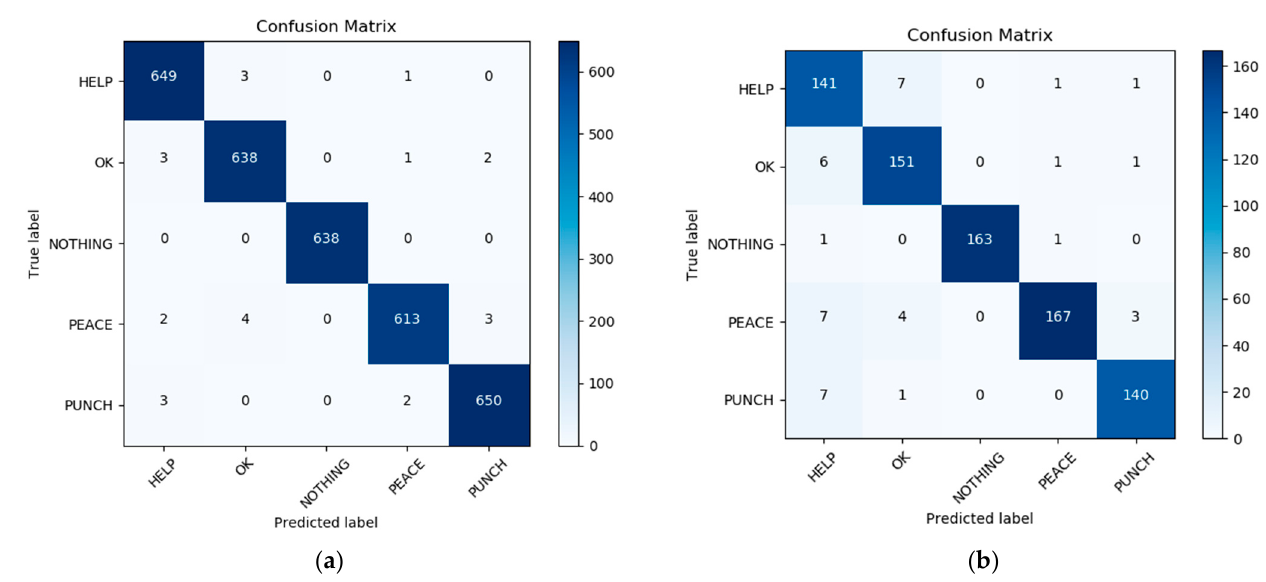
Figure 15. Confusion matrix with predicted labels on X -axis and true labels on the Y -axis tested on hand gesture training set ( a ) and in testing dataset ( b ).